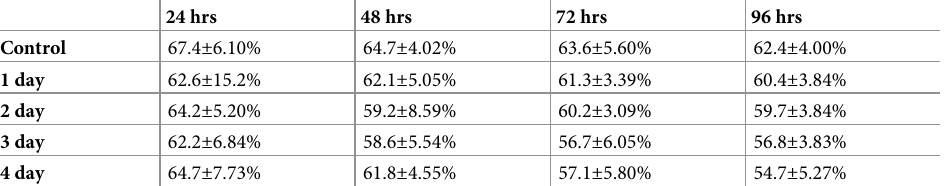
Table 1. Proportion of apoptotic cell loss (%) at 24, 48, 72 and 96 hours in control (no PBM) 1, 2, 3, and 4 consecu- tive days of